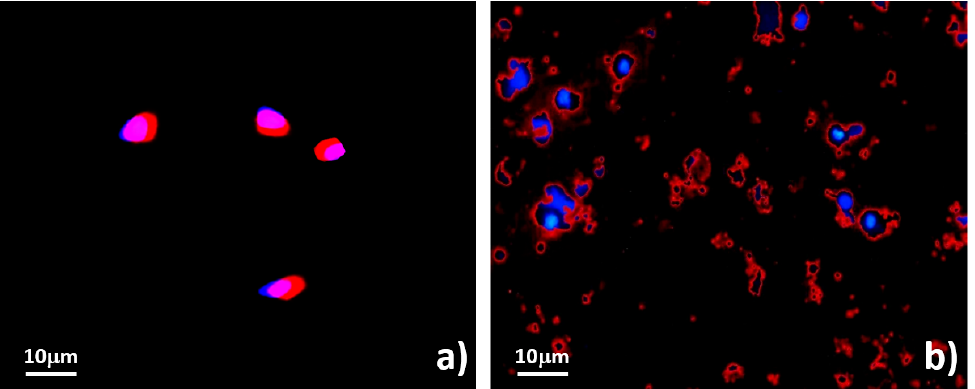
Figure 9. The functional viability of unsorted and sorted MCT cells with TMRM. ( a ) Unsorted MCT cells were positive for TMRM, of which the fluorescent signals were observed throughout the cytoplasm of the cells. Moreover, the method could clearly verify the morphology of both normal and necrotic MCT cells. ( b ) TMRM fluorescent signals were mainly positive at the perimeter of the cells. In addition, most sorted cells had erratic configurations.